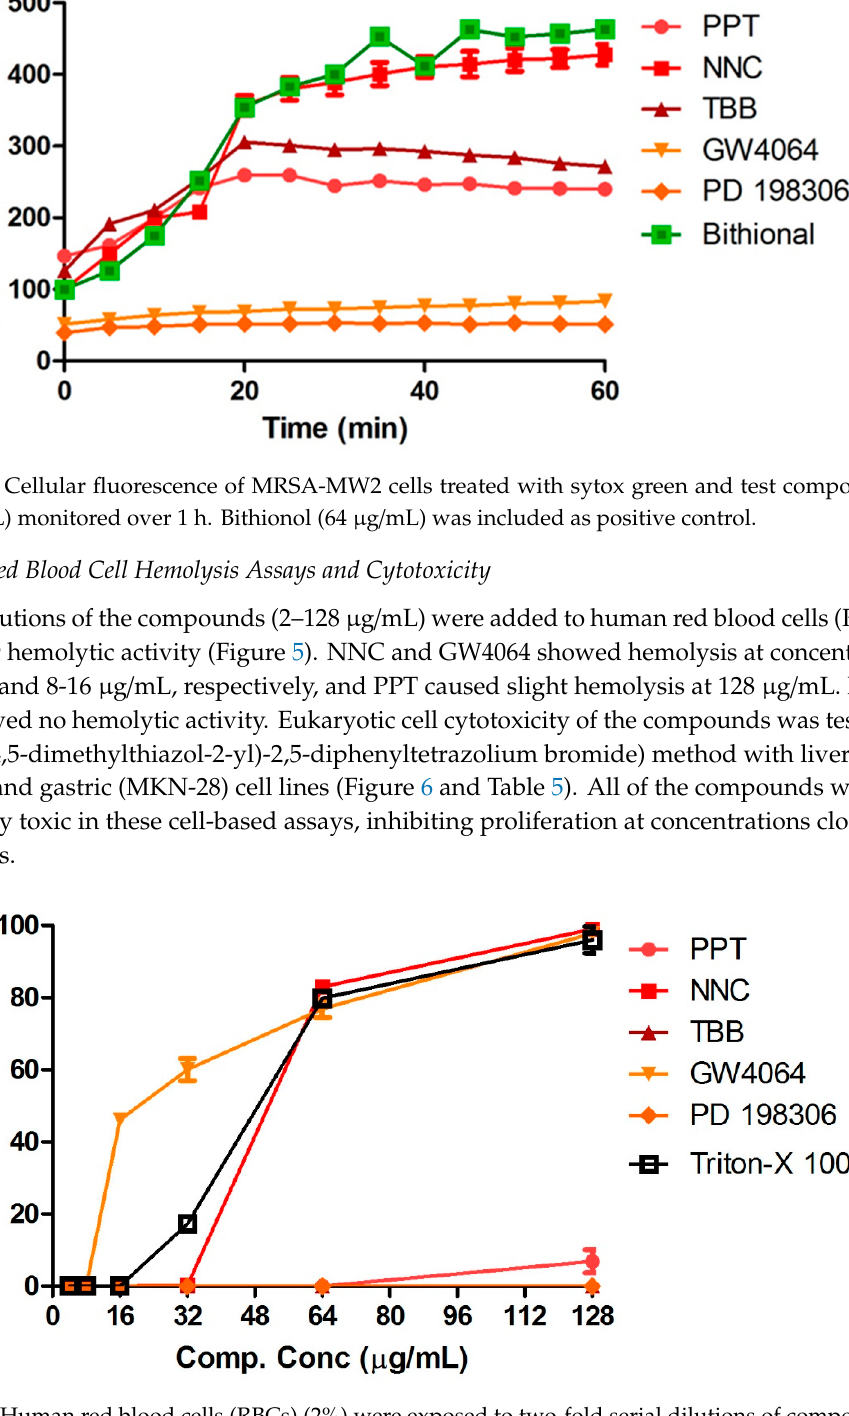
Figure 5. Human red blood cells (RBCs) (2%) were exposed to two-fold serial dilutions of compounds and hemolysis was measured after 1 hr. A sample treated with 1% Triton-X 100, which causes 100% hemolysis, was used as the positive control.